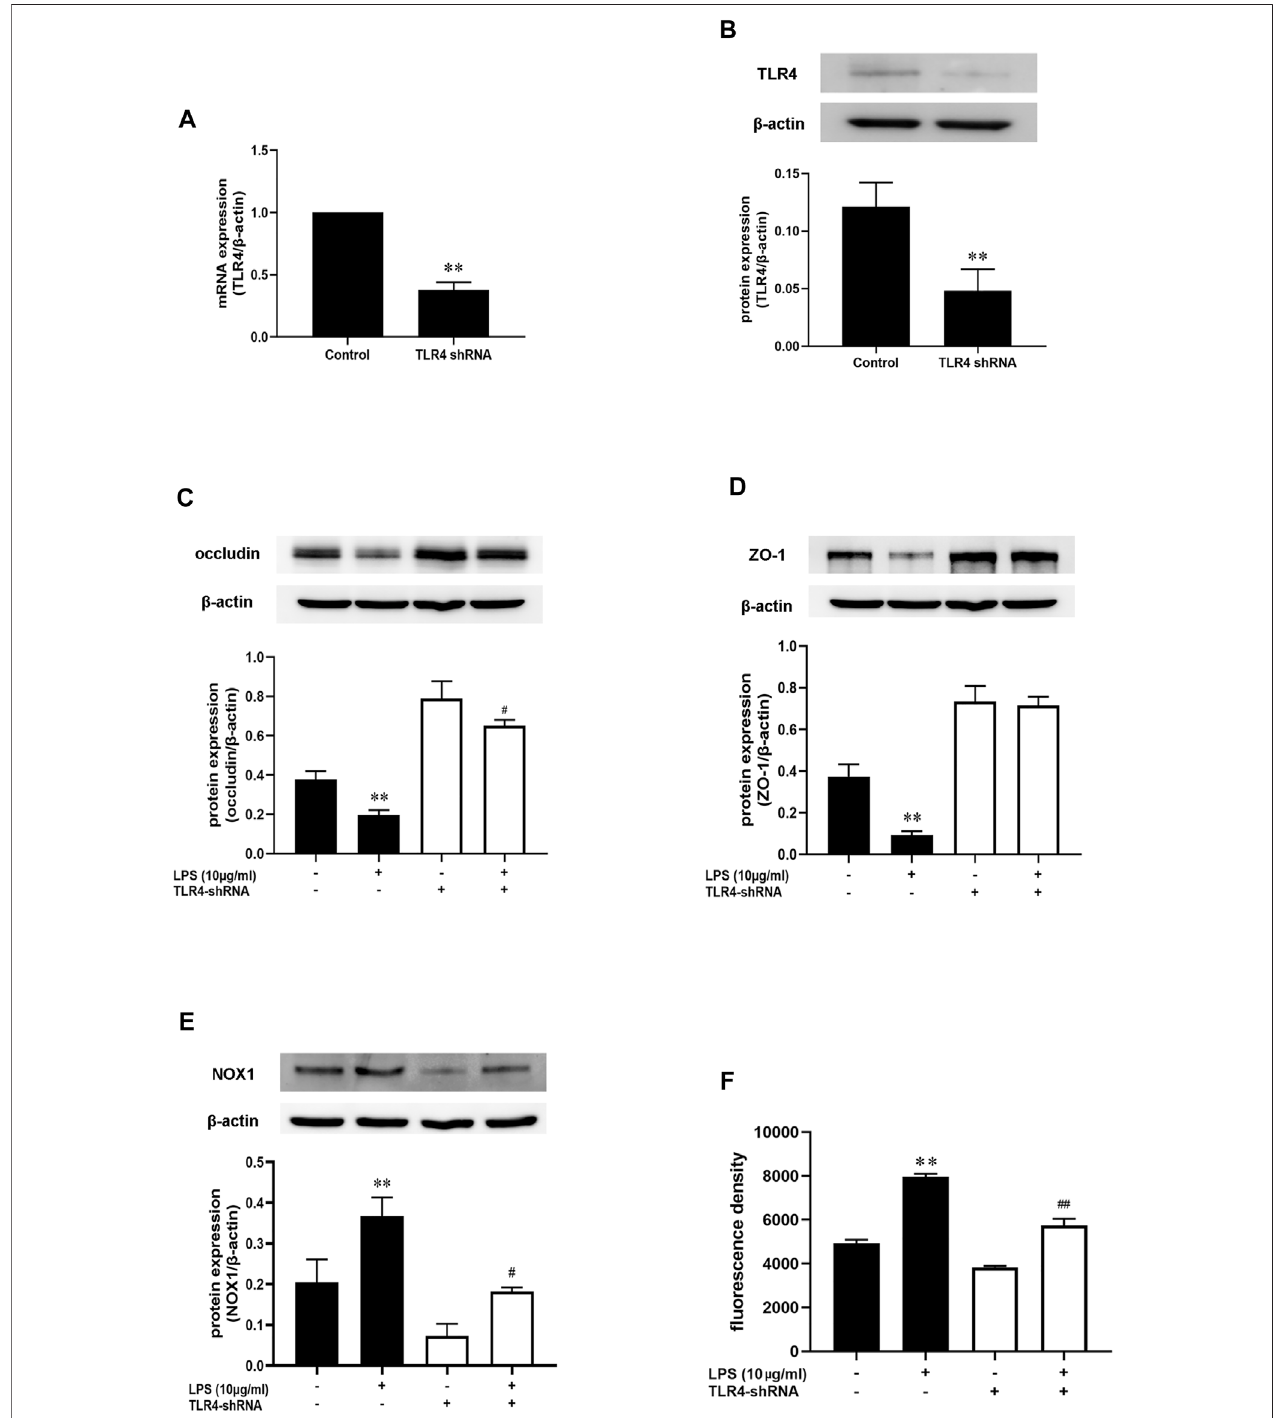
FIGURE9| AB23AeffectsontheLPS-inducedintestinalbarrierpermeabilitybyinhibitingtheTLR4-NOX1/ROSpathway.FollowingtransfectionwithTLR4shRNA, thecellsweresubsequentlyculturedfor48 hbeforebeingtreatedwithLPSfor12 h. (A,B) ThemRNAandproteinexpressionlevelofTLR4. (C,D) TheoccludinandZO-1 protein expression level. (E) The NOX1 protein expression level after transfected with TLR4-shRNA with or without LPS stimulation. (F) The ROS production following transfection with TLR4-shRNA with or without LPS stimulation. All gel images are from the same sample. β -actin was utilized repeatedly as a control image. ** p < 0.01 vs. control; # p < 0.05 vs. TLR4-shRNA + LPS (10 μ g/ml); ## p < 0.01 vs. TLR4-shRNA + LPS (10 μ g/ml).